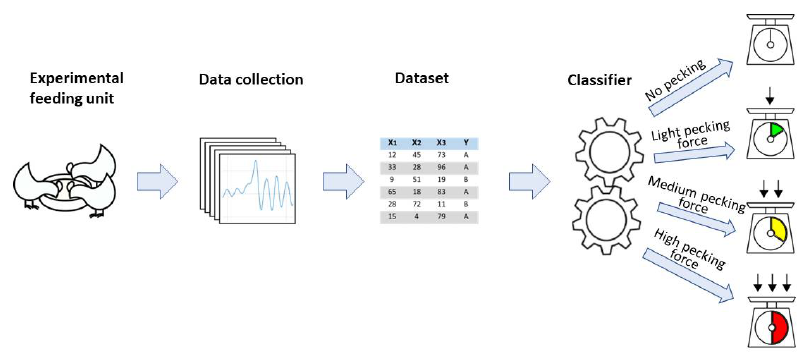
Figure 2. Schematic view of the process used in the current study.